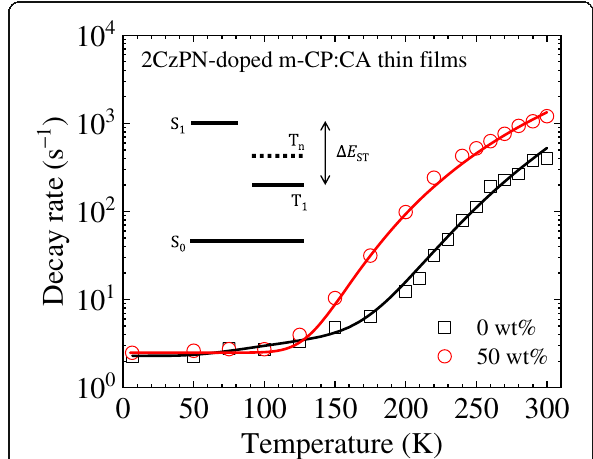
Fig. 5 Temperature dependence of the decay rate of 2CzPN-doped m-CP:CA thin films. Solid lines are fitted results based on a four-level model shown in the